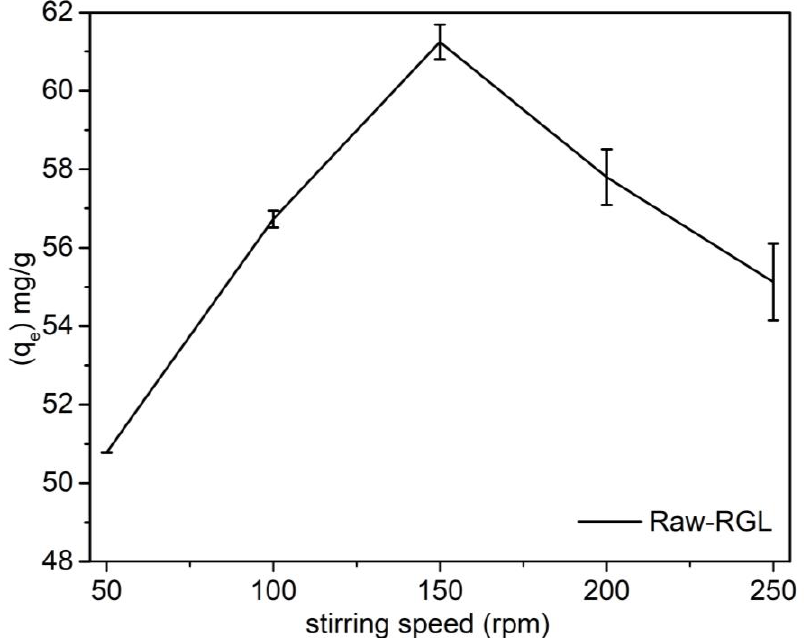
Figure 10. Effect of stirring speed on ibuprofen uptake by Raw-RGL adsorbents.